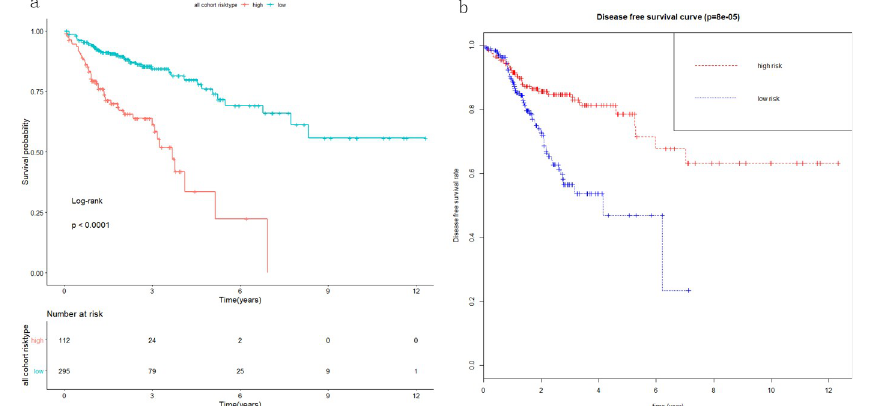
Fig 3. Survival and disease-free survival analyses in the combined cohort. The survival curve (a) and disease-free survival (b) were calculated for the combined cohort according to the miRNA signature by Kaplan-Meier and log- rank.